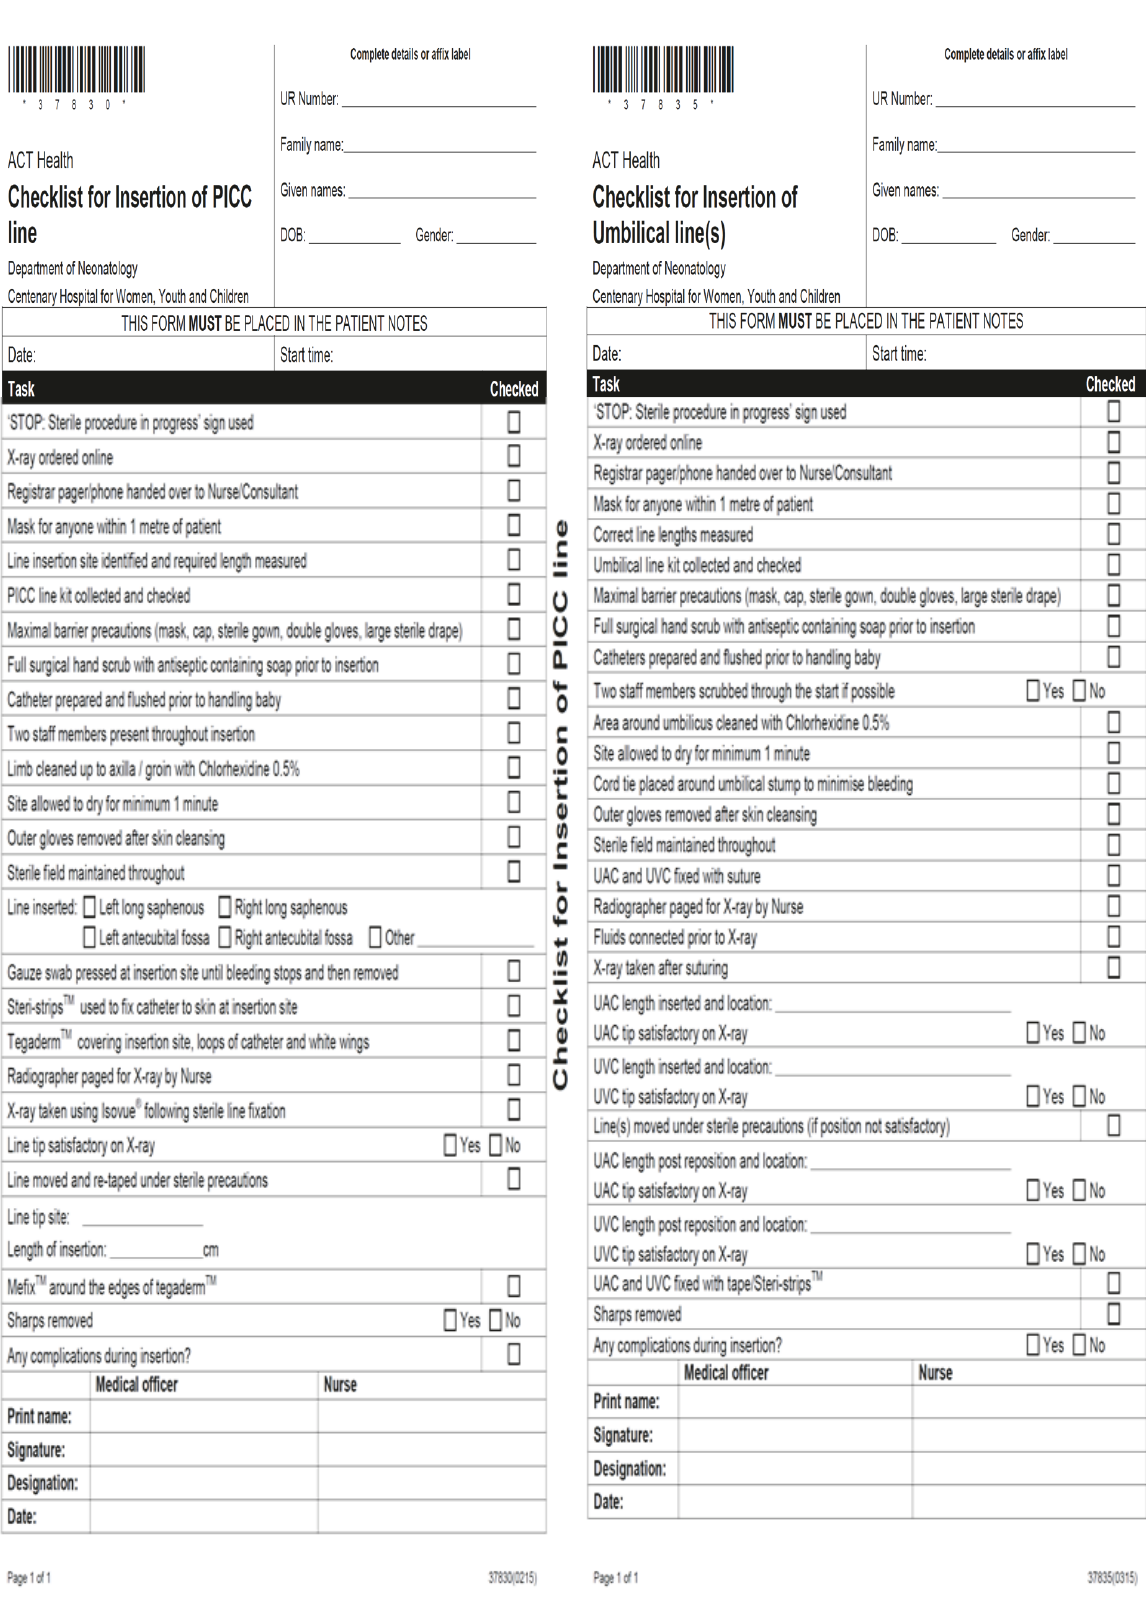
Figure 1: Insertion checklist for peripherally inserted central catheters and umbilical